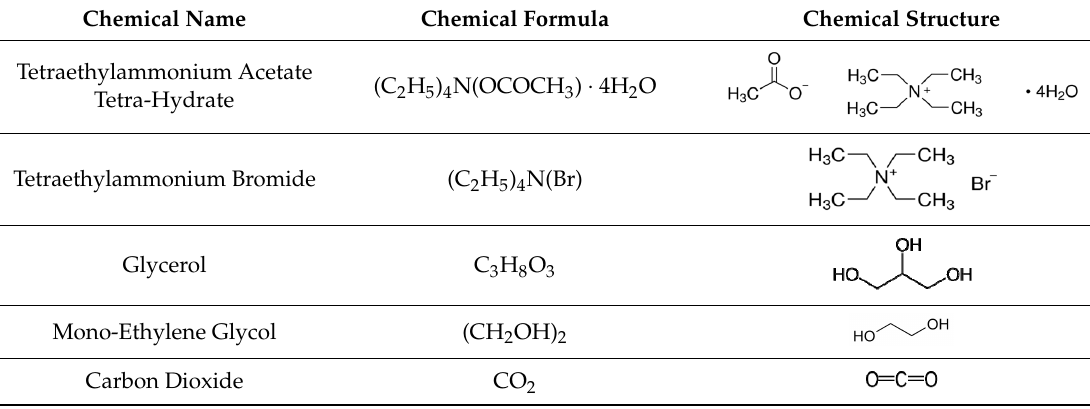
Table 1. List of Table 1. List of chemicals.